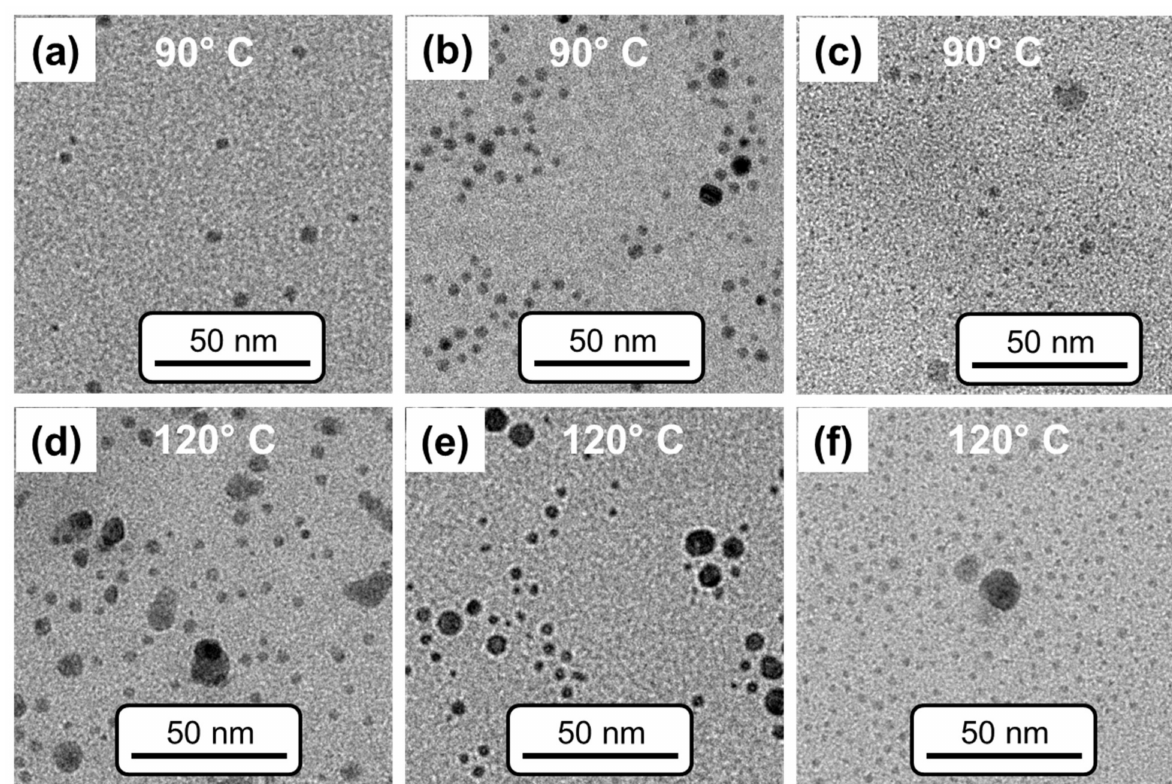
Figure 4. TEM images of M-AgNPs, D-AgNPs, and T-AgNPs, prepared at two different temperatures (90 ◦ C ( a – c ) and 120 ◦ C ( d – f )),